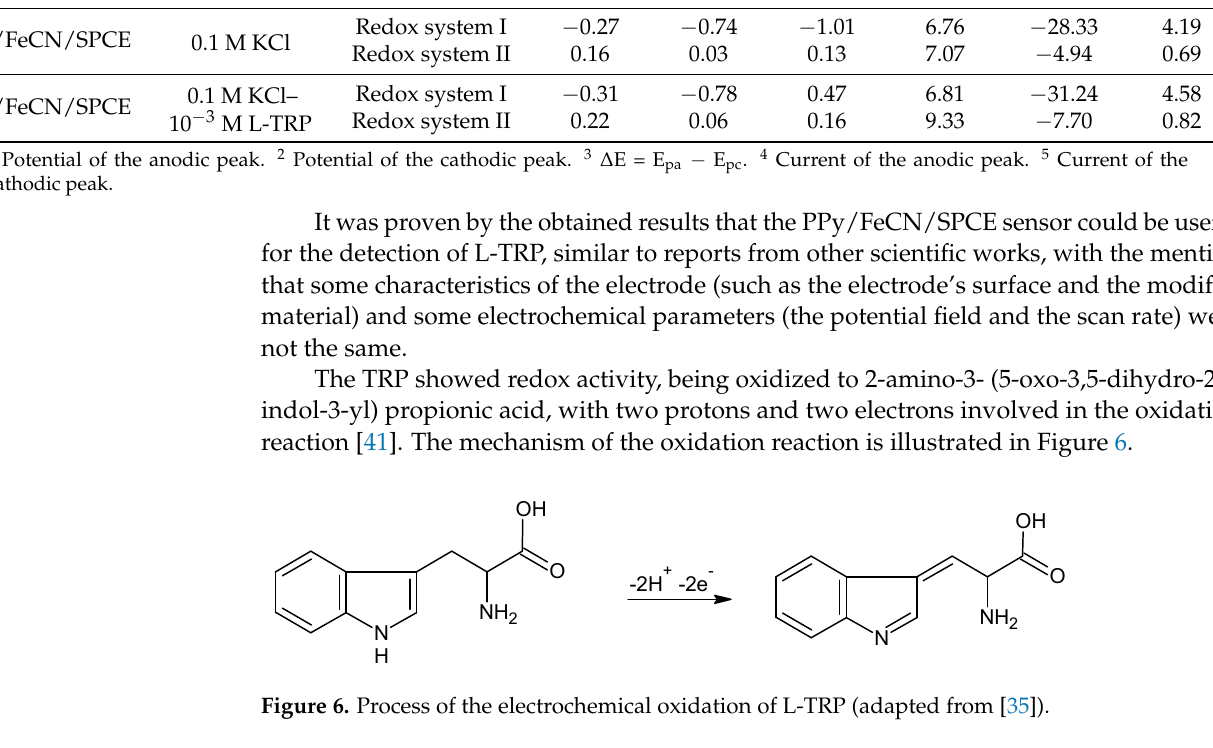
Table 3. The potentials and currents of the peaks of PPy-modified sensors and immersed in a 0.1 M KCl solution and in a double solution 0.1 M KCl–10 − 3 M L-TRP at scan rate of 0.1 V × s − 1 .